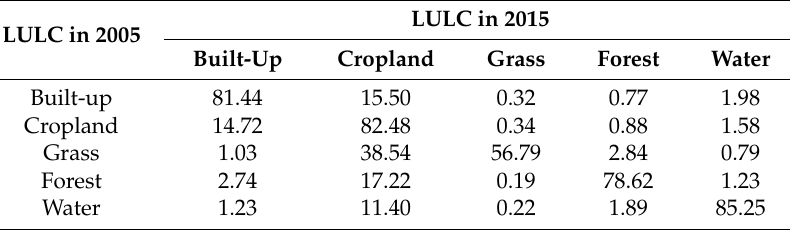
Table A5. Matrix of transition probability in LULC, 2005–2015